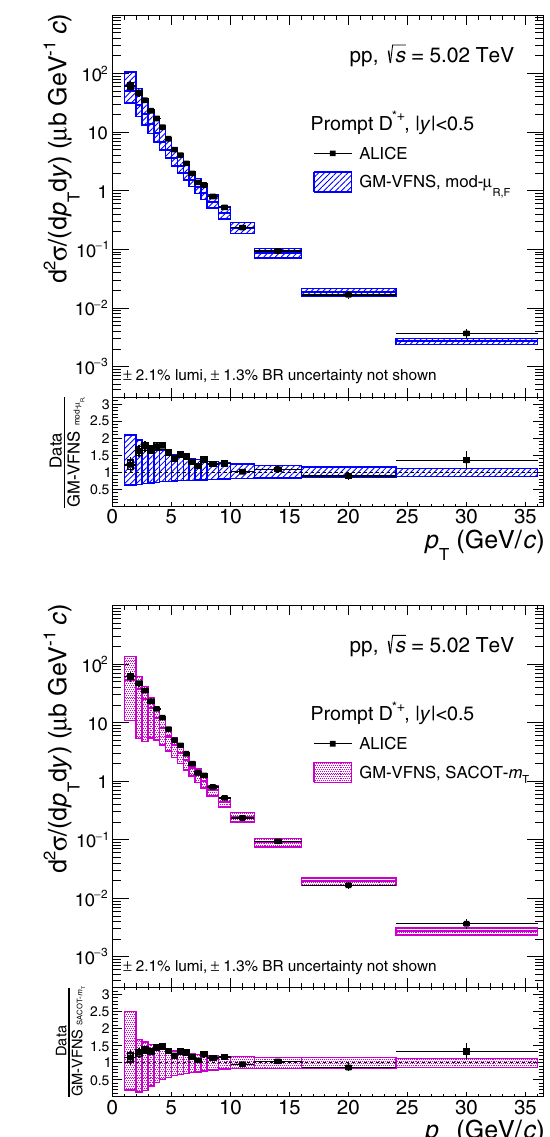
factorisation [41]. The ratios of the data to the theoretical predictions are shown in the lower part of each panel